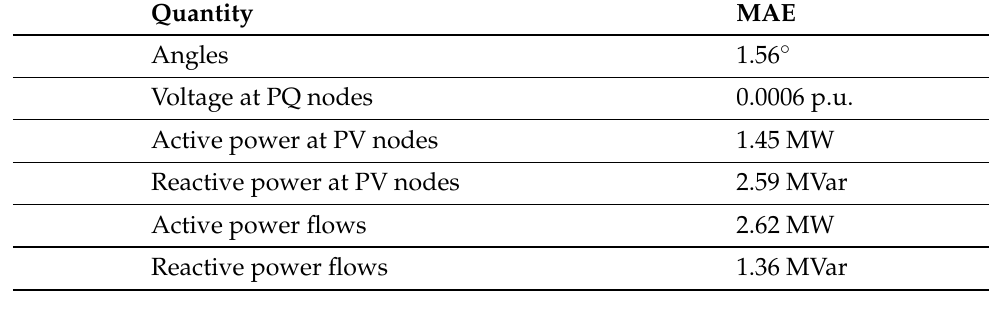
Table 6. KPI for the AC power flow linearization.